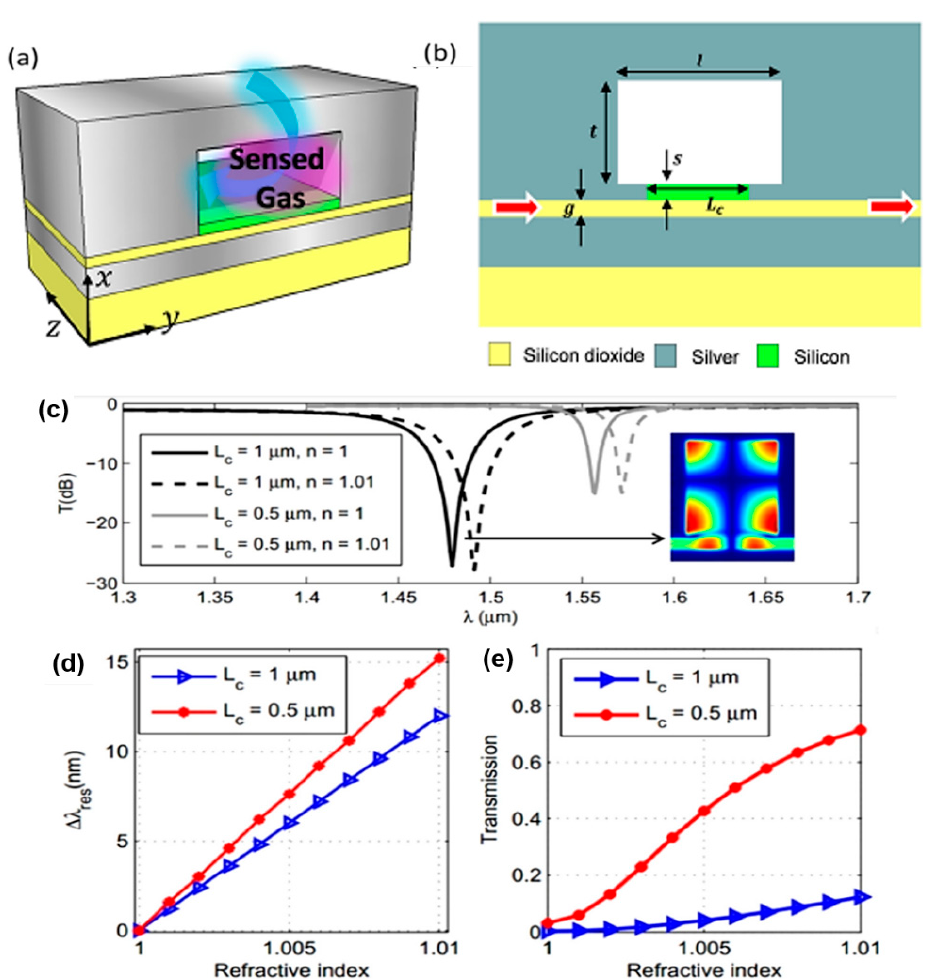
Figure 19. Schematic diagram of the plasmonic sensor with geometrical parameters symbols: ( a ) 3D illustration of the resonator in sensing application, ( b ) 2D sensor schematics, sensing characteristics of the 1 µ m × 1 µ m cavity of ( c ) Transmission spectra for different refractive indices of the cavity filling material and different coupling lengths (L c ), inset showing the magnetic field profile of the resonant mode for L c = 1 µ m. ( d ) Resonance wavelength versus the refractive index. ( e ) Sensor’s transmission versus refractive index at the resonant wavelengths. © IOP Publishing. Reproduced with permission. All rights reserved.